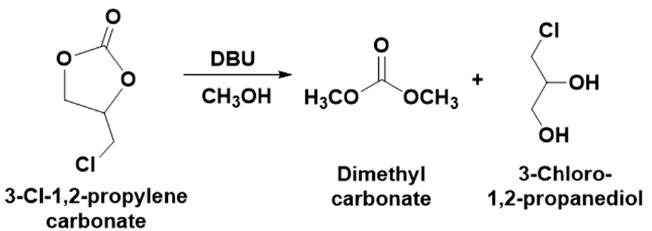
Figure 4 . 13 C NMR spectra of the ( a ) 1,3-dichloro-2-propanol in 2-Me-THF, ( b ) DBU and, ( c ) Reaction mixture after equivalent interaction of 1,3-dichloro-2-propanol, DBU, and CO 2 in 2-Me-THF,